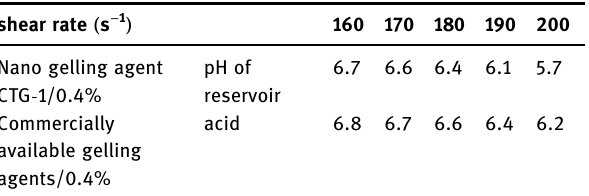
Table 5: E ff ect of shear rate on acid fl uid loss coe ffi cient of carbo - nate rock reservoirs